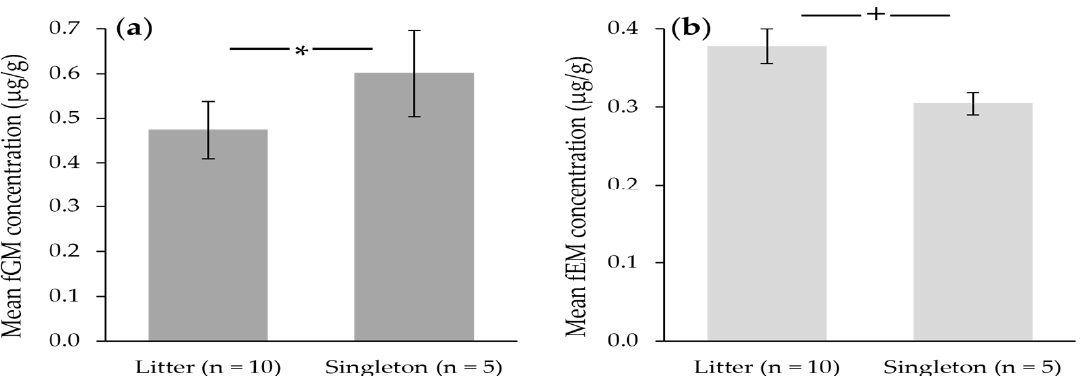
Figure 4. Raw ( a ) fecal glucocorticoid metabolite (fGM) and ( b ) fecal estrogen metabolite (fEM) means for pregnant female cheetahs that gave birth to a litter of more than one offspring ( n = 10) compared to hormone concentrations collected during pregnancies in which females gave birth to a singleton cub ( n = 5). Asterisk denotes significance ( p < 0.05), and plus sign denotes a tendency ( p =